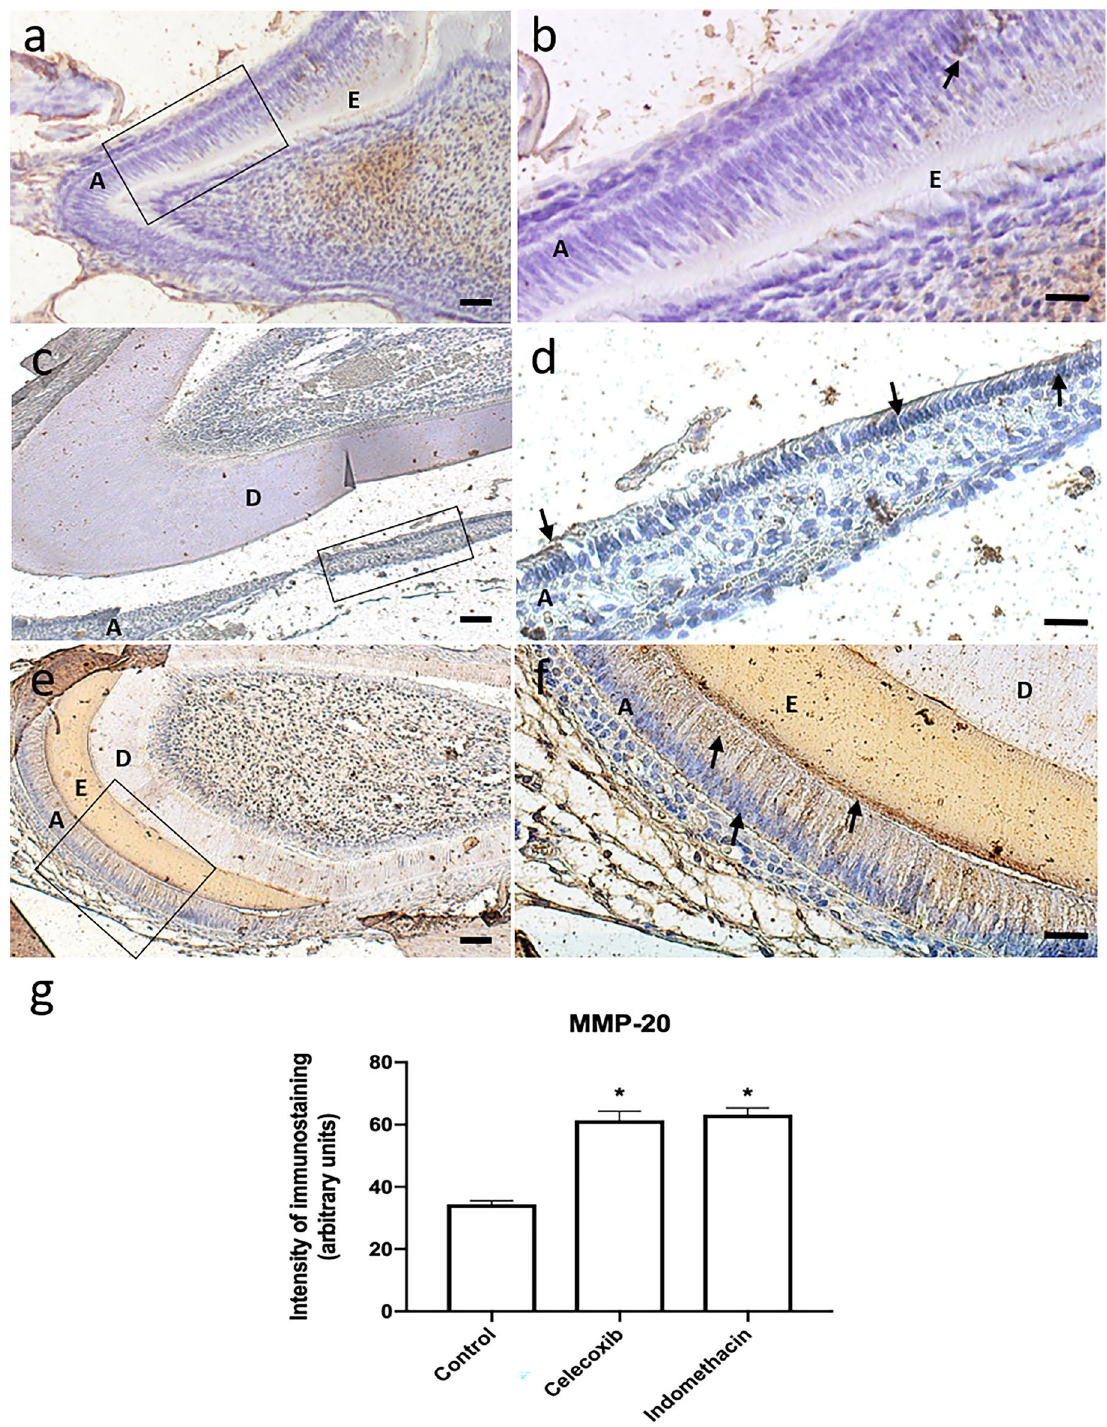
Figure 4. Expression of MMP-20 in the control group (n = 20) (10 × / scale = 100 µm) ( a ), (20×/scale = 50 µm) ( b ). High expression of MMP-20 in the group treated with Celecoxib (n = 20) (10×/scale = 100 µm) ( c ), (20×/ scale = 50 µm) ( d ) and Indomethacin (n = 20) (10×/scale = 100 µm) ( e ), (20×/scale = 50 µm) ( f ). Graphical representation of immunostaining quantification of MMP-20 protein synthesis using image deconvolution- median and interquartile range ( g ). A: ameloblasts, E: enamel layer, D: dentin